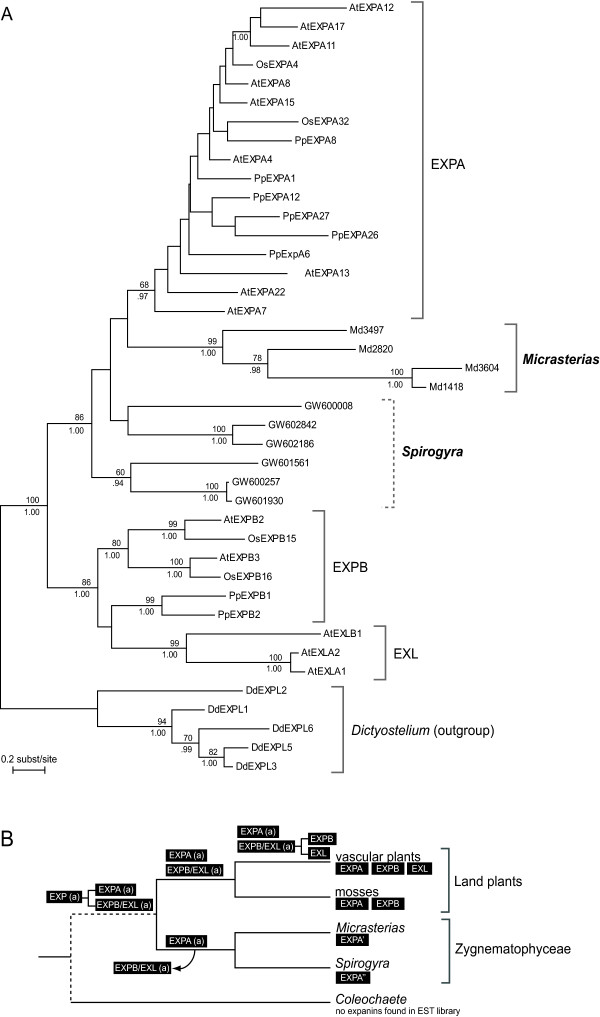
Maximum likelihood phylogeny of the plant expansin gene family (A) Maximum likelihood (ML) phylogeny of the plant expansin gene family, showing the phylogenetic position of the Micrasterias and Spirogyra genes. Numbers at nodes indicate ML bootstrap values (top) and Bayesian posterior probabilities (bottom); values below 50 and 0.9, respectively, are not shown. Dd, Dictyostelium discoideum (outgroup); Pp, Physcomitrella patens; Os, Oryza sativa; At, Arabidopsis thaliana. (B) Possible events hypothetically explaining the distribution of expansin gene families in land plants and Zygnematophyceae. The organismal tree is based on multigene phylogenetic analyses [5,6] and only includes taxa in which expansins have been found, along with Coleochaete that apparently lacks expansins based on transcriptome analyses [27]. The dotted line in the tree indicates phylogenetic uncertainty. "(a)" marks ancestral gene families, EXPA' and EXPA'' represent the EXPA-related genes found in Micrasterias and Spirogyra respectively.